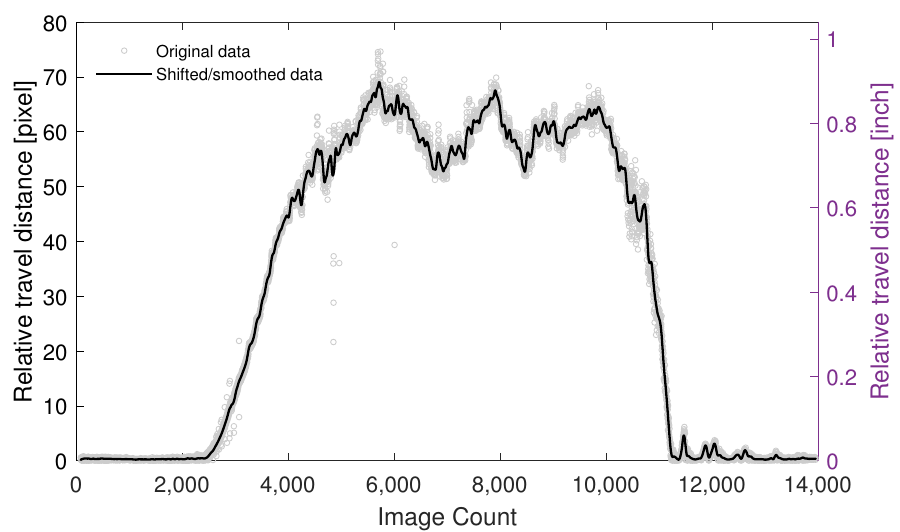
Figure 12. Relative travel distance for a test run. Each data point represents the relative travel distance of the corresponding image count with respect to the previous image